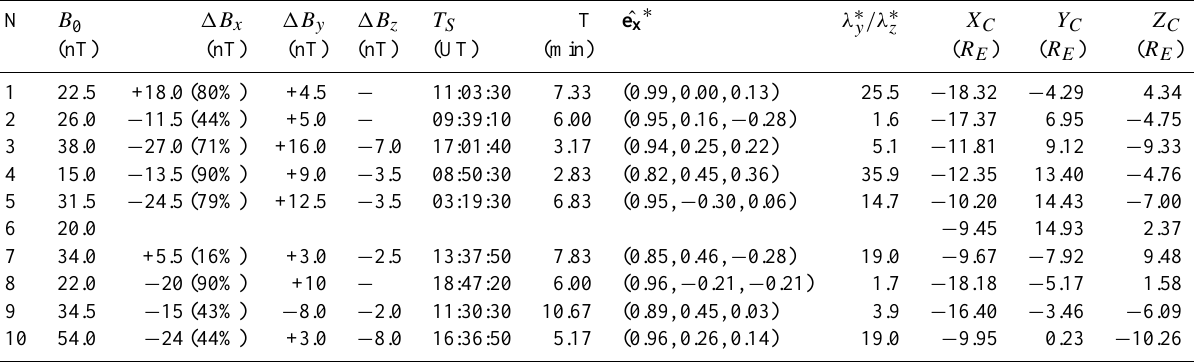
Table 2. Tail lobe SI events. Values are taken from C3, except for 18 August 2002, for which the C1 data were used. Panels show: the initial magnetic field magnitude ( B 0 ), the total amount of the change in B x (the percentage of the B 0 shown in parenthesis), the amplitude of the change in GSM B y and B z , the start time ( T S ) and the duration of the SI, the direction of the maximum variance vector ˆ e x ∗ in GSM, the eigenvalue ratio ( λ ∗ y /λ ∗ z ), and the C3 location in